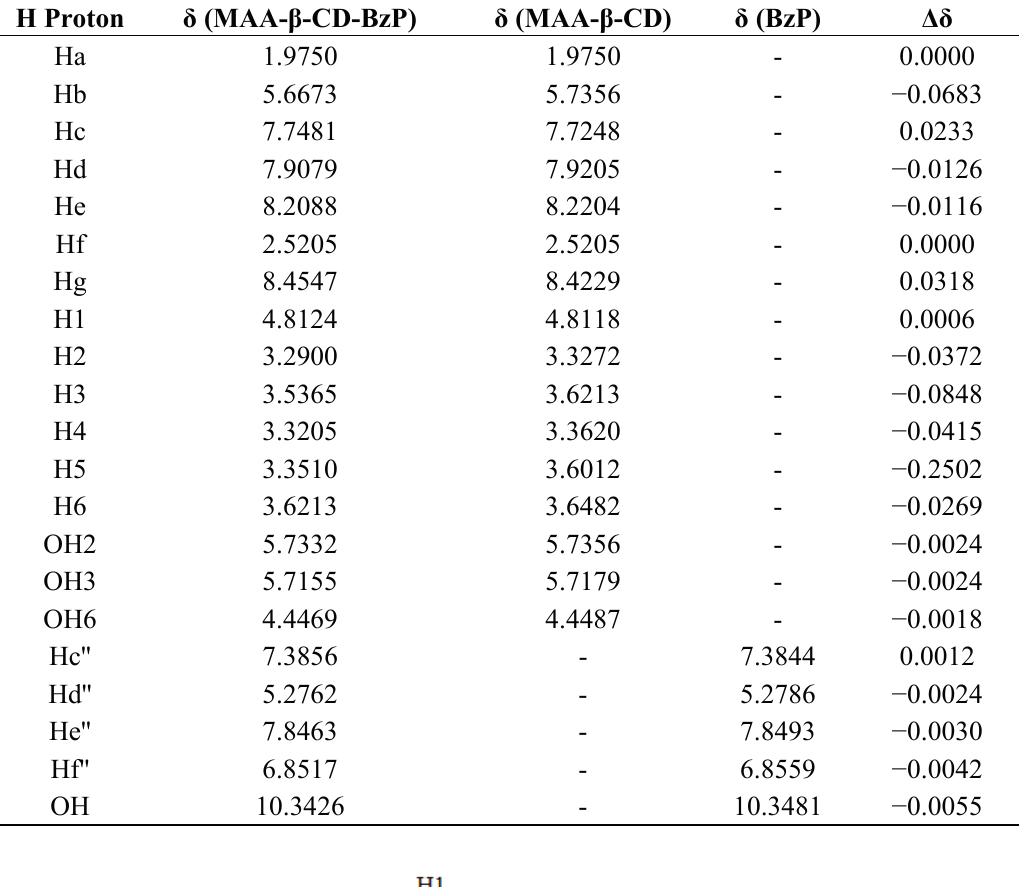
Table 4. 1 H NMR chemical shift (ppm) for MAA- β -CD, BzP, and MAA- β -CD-BzP.